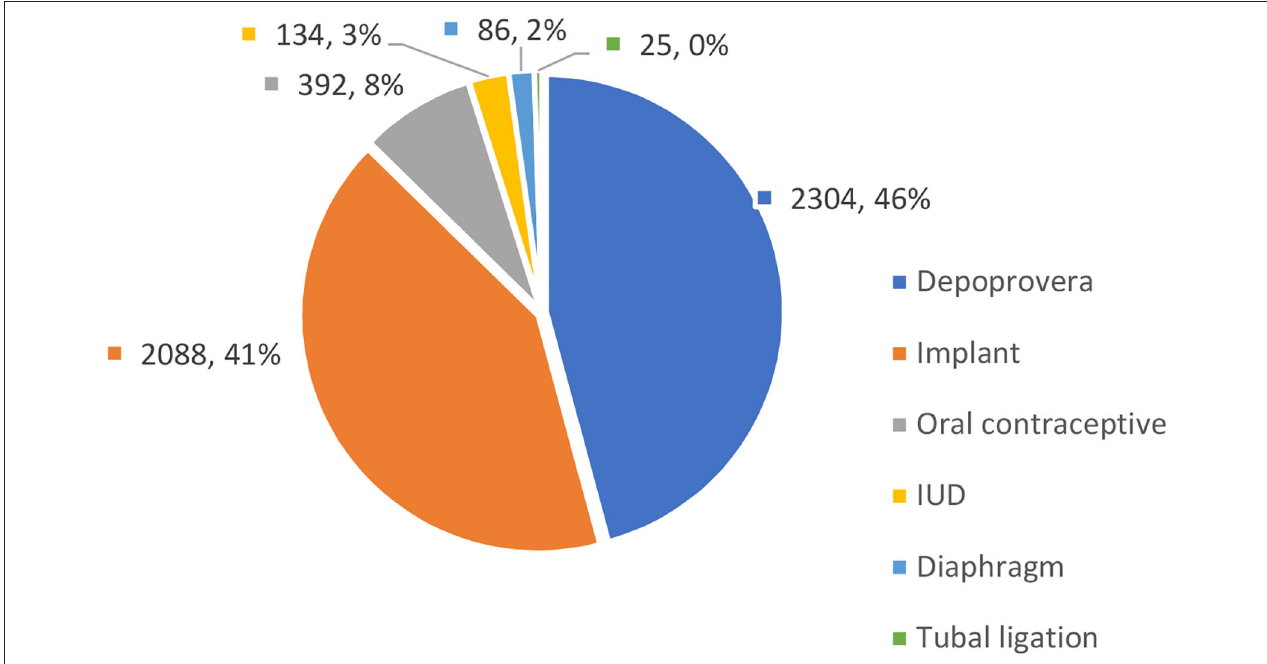
FIGURE 3 | Method mix for non-barrier contraceptive methods among female sex workers (FSWs) ( n =